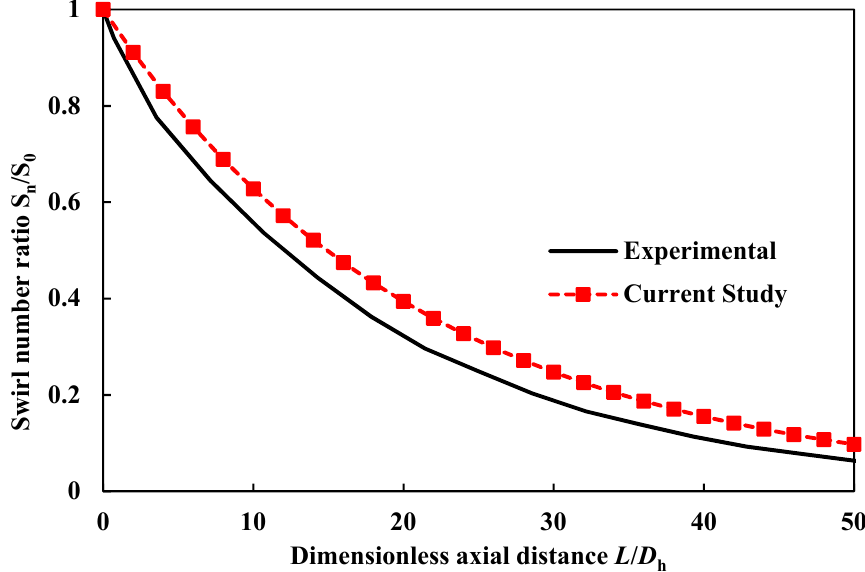
Figure 3. Validation for present prediction with experiment results from Fokeer et al. [9,24].